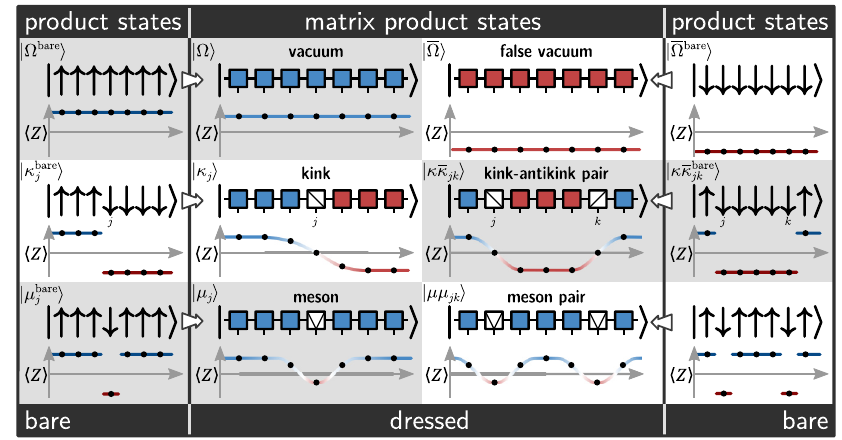
FIG. 4. Diagram illustrating the various types of states, and their spin profiles, rel- evant for simulations. For example, our initial states are wavepackets constructed from kink-antikink pairs. The product states listed are eigenstates of H when g = 0, λ = 0. Away from this regime, we use MPSs to accurately capture fluctuations in the vacua, as well as the quasilocal nature of the excited quasiparticle